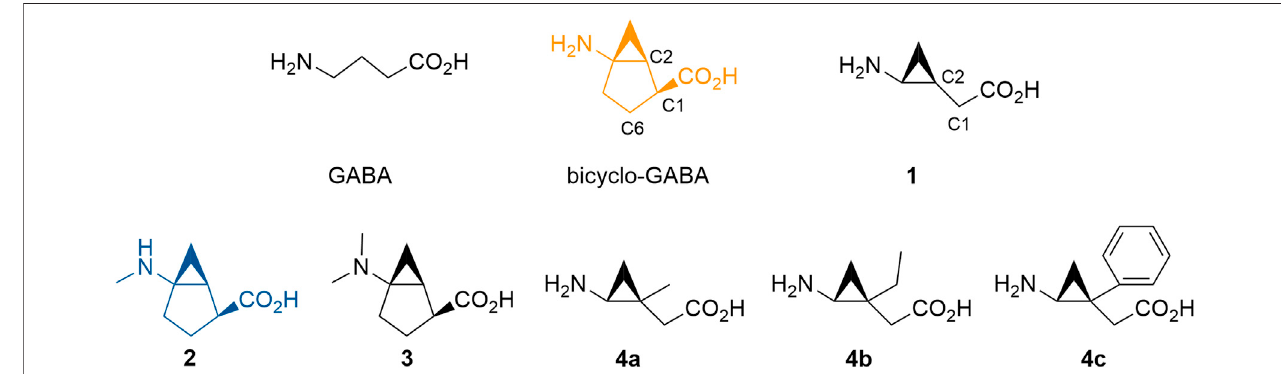
FIGURE1| GABAandnovelanalogsofbicyclo-GABAand 1 usedinthisstudy.Thecolorcodeforbicyclo-GABA(orange)and 2